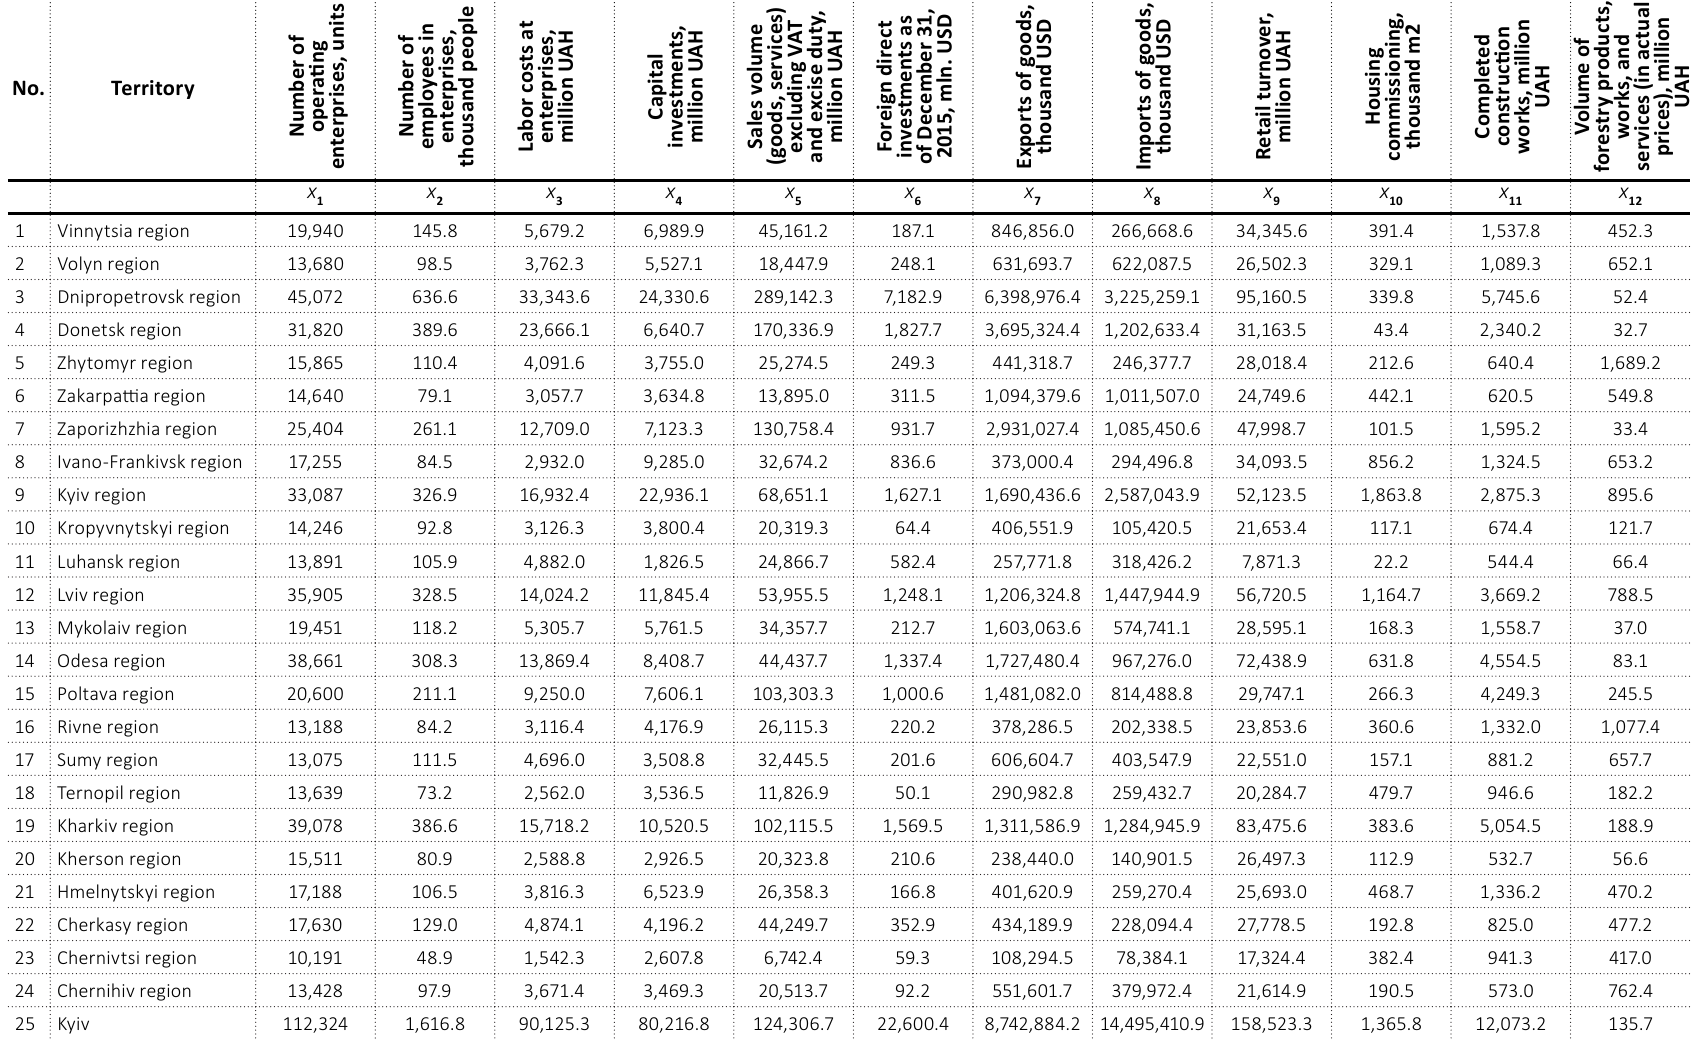
Source: Compiled according to the data of the State Statistics Service of